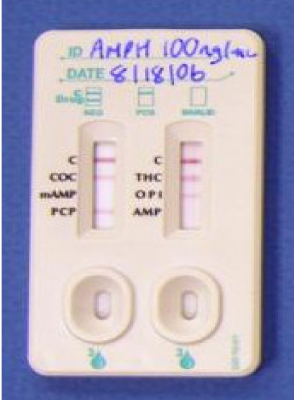
Figure 9. AconLabs Oral Fluid Drug Screen device